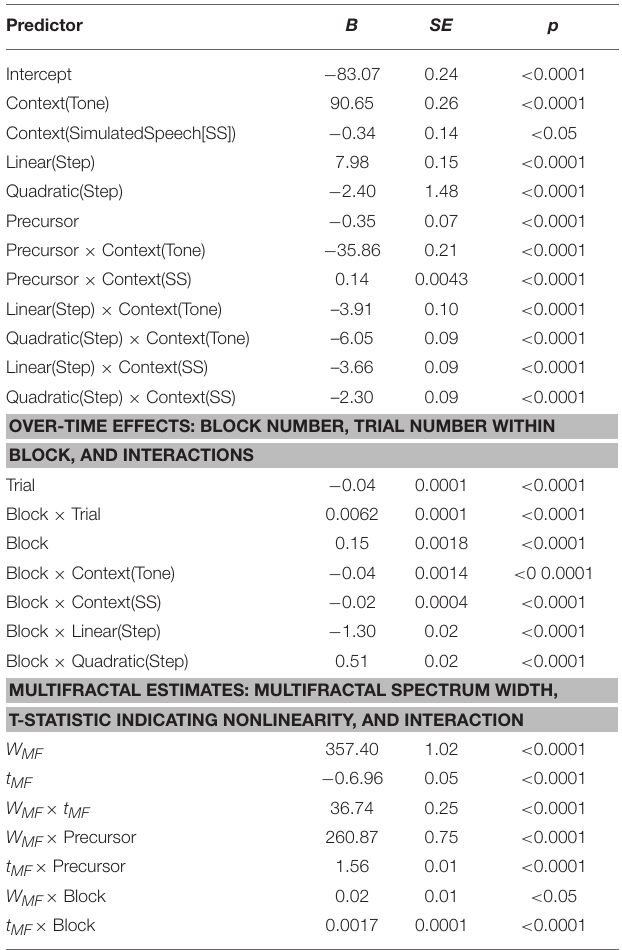
TABLE 3 | All coefficients from Poisson regression predicting response times